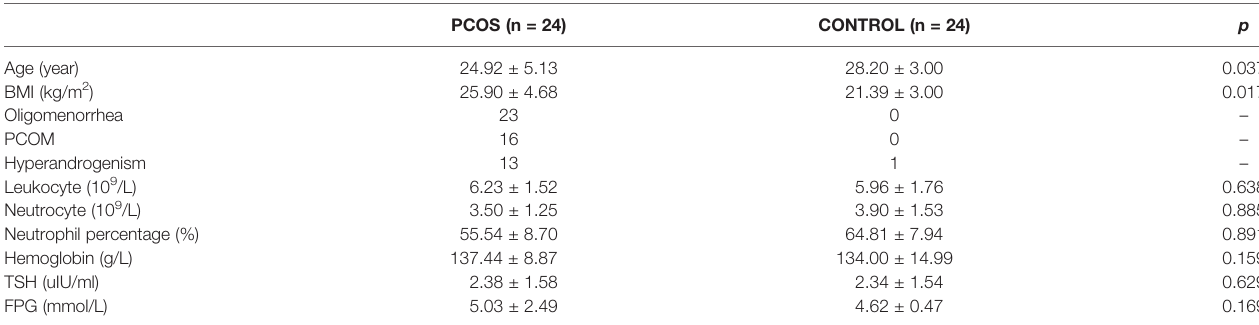
TABLE 1 | Baseline characteristics of